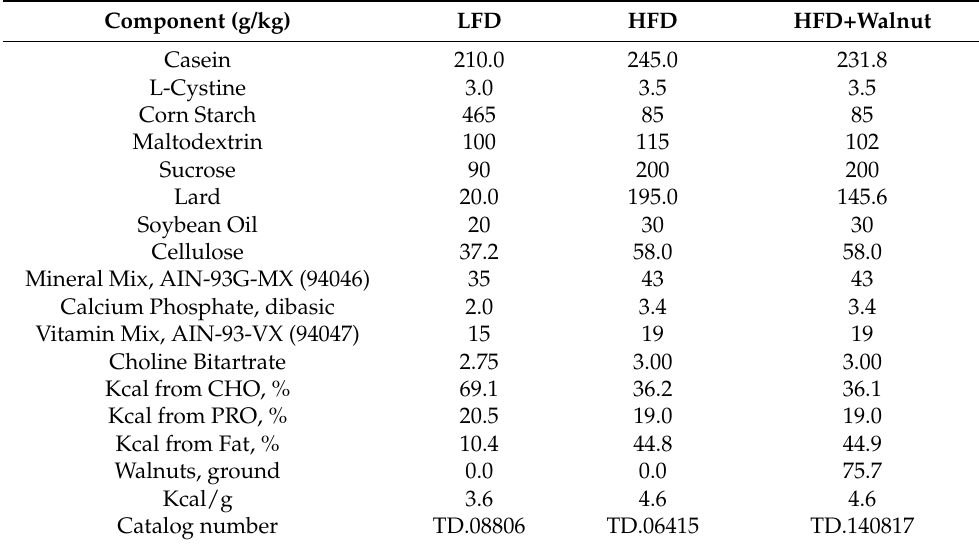
Table 3. Composition of the purified diet